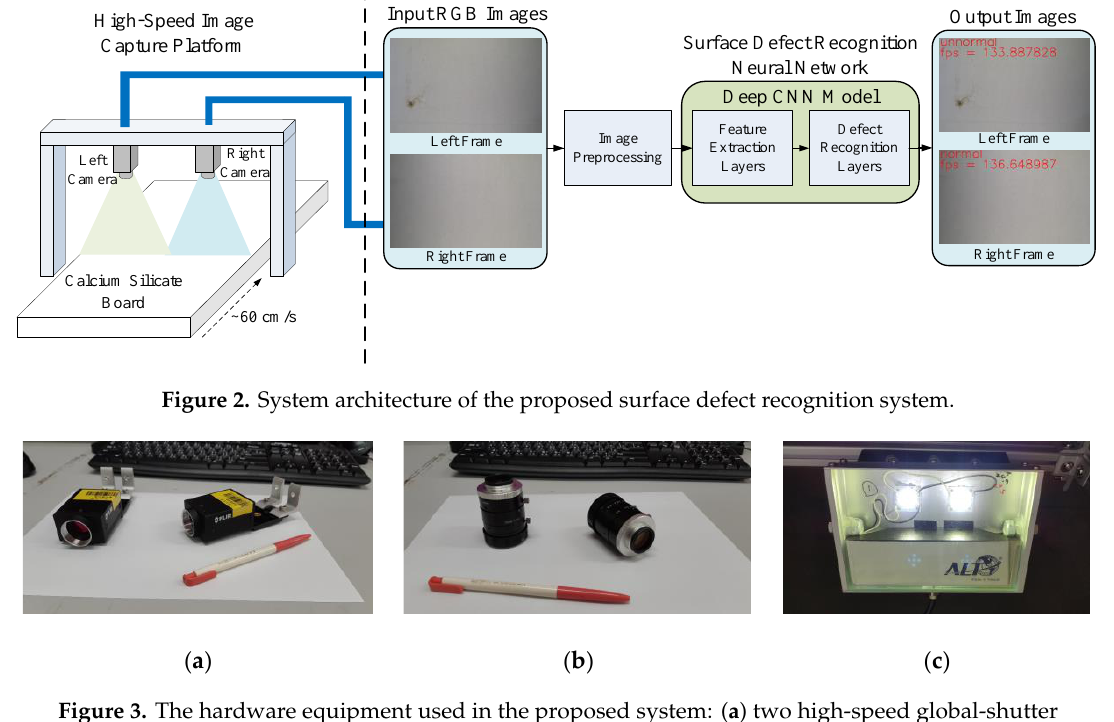
Figure 3. The hardware equipment used in the proposed system: ( a ) two high-speed global-shutter cameras (Grasshopper3, USB3.0, 2.3 million), ( b ) two camera lenses (1”12mm, F1.4, C-mount), and ( c ) four DC LED light sources.